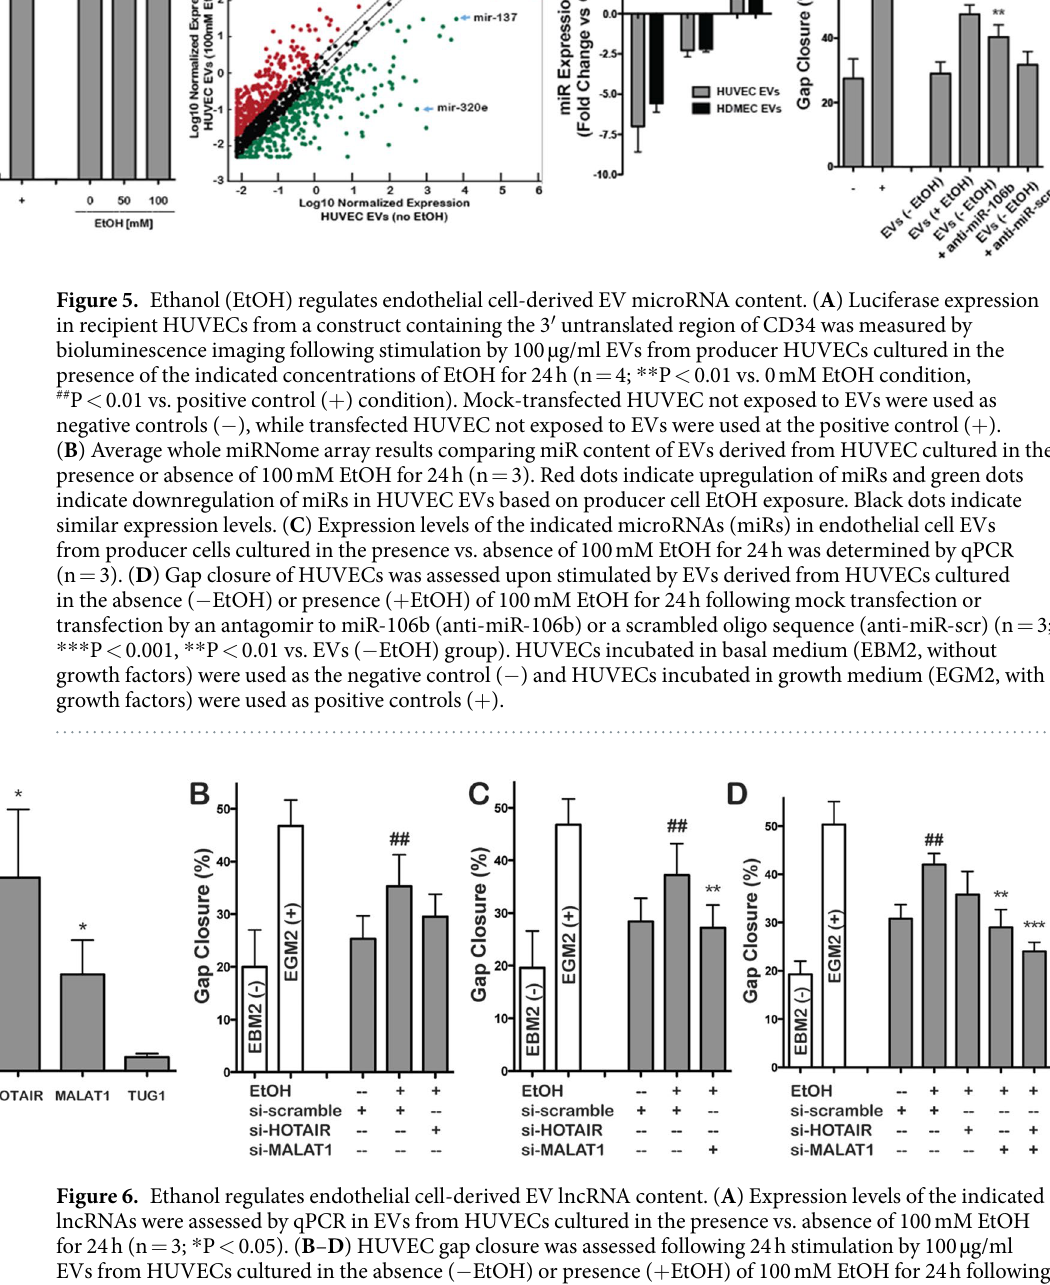
and MALAT1 (double transfection, Fig. 6D) or a scrambled siRNA sequence. The depletion of HOTAIR and MALAT1 from cellular RNA and EV RNA was confirmed by q-PCR (Supplementary Figs S3 and S4). The cells were then cultured in the presence or absence of 100 mM ethanol and assessment of the vascularization bioac- tivity of the EVs isolated from these groups of cells was conducted using endothelial gap closure assays. These experiments revealed that downregulating MALAT1 expression alone and MALAT1 and HOTAIR expression together significantly abrogated the increase in vascularization bioactivity in HUVEC EVs associated with